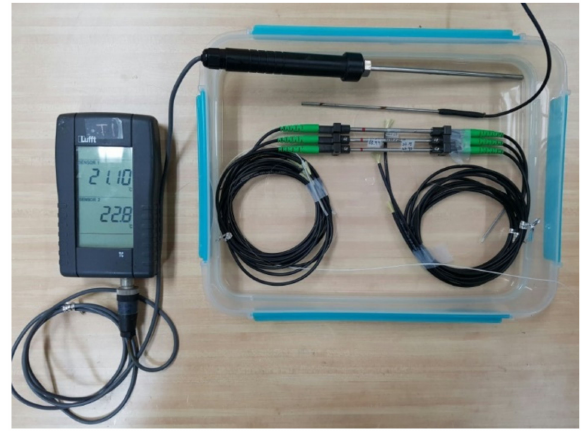
Figure 5. Submergence test of the FBG